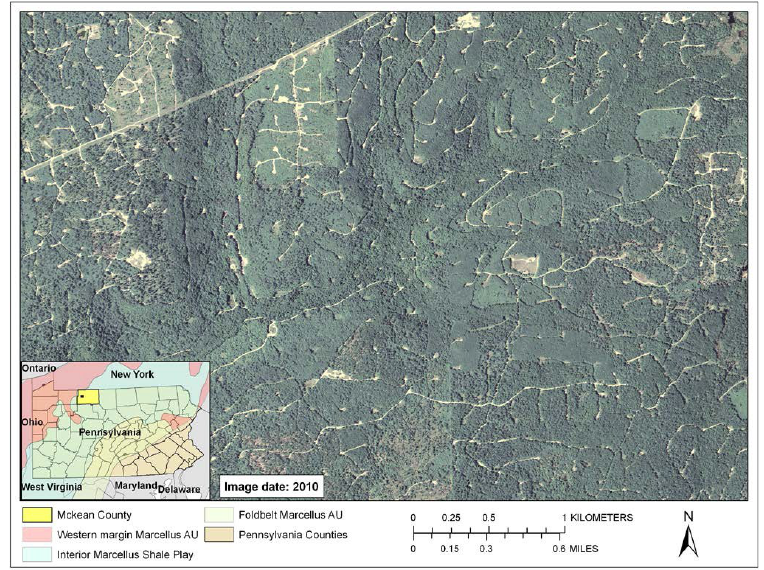
Figure 2. A forested landscape in McKean County, Pennsylvania, showing the distribution of roads, well pads and pipelines related to combined hydrocarbon development. This particular pattern of disturbance is primarily the result of conventional oil and gas development, but highlights the combined effects of decades of hydrocarbon extraction in Pennsylvania. Source: National Agricultural Imagery